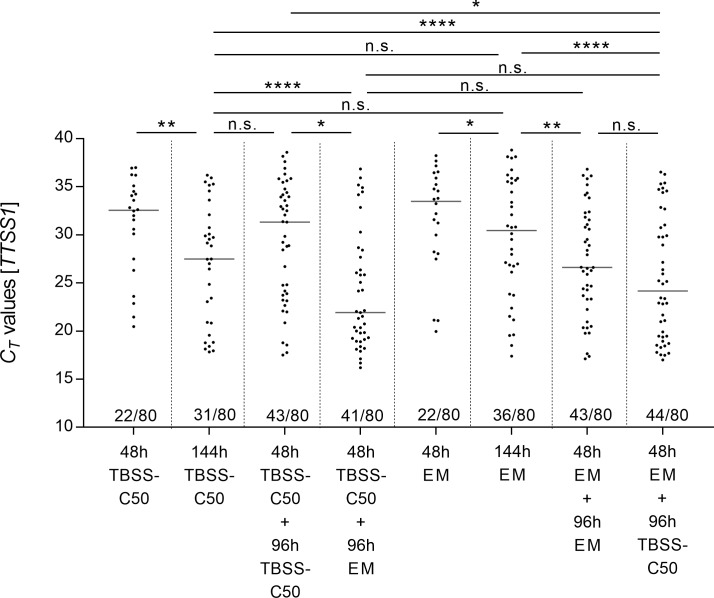
Enrichment of B. pseudomallei from soil samples using different culture conditions.Eighty soil samples collected from 16 rice paddies in different parts of Vietnam were subjected to eight different culture conditions using either TBSS-C50 or EM in single step cultures (48h or 144h) or in two step cultures with both media in various combinations (48h plus 96h) as indicated. B. pseudomallei growth was assessed by B. pseudomallei-specific qPCR at the end of each incubation of those 640 cultures. Detectable qPCR cycle threshold (CT) values with corresponding medians of 51 soil samples cultured in different enrichment methods are plotted in the graph. Each dot represents a single sample. The total numbers of qPCR-positive samples for each culture condition are shown below the corresponding dots above the abscissa. Significance analyses between the CT values were performed using the Friedman´s test with a CT value of 39 designated to qPCR-negative supernatants (*p<0.05.; **p<0.01; ***p<0.001; ****p<0,0001).